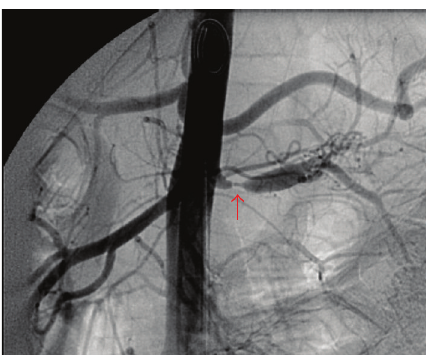
Figure 1: Angiography showing a short high grade stenosis (arrow) and poststenotic dilatation of the left renal artery.